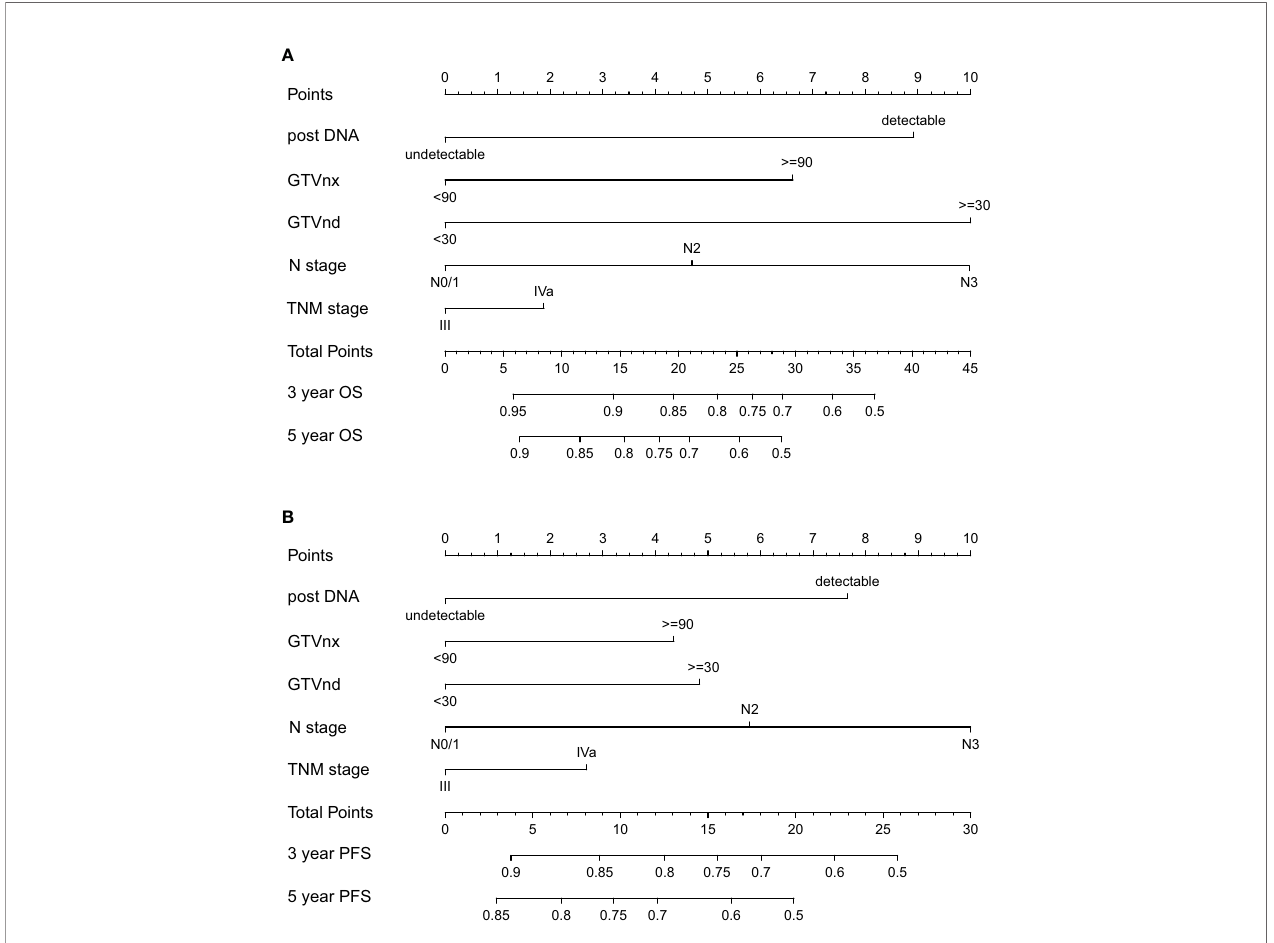
FIGURE 1 | Nomogram integrating N stage, TNM stage and all independent clinical factors (post-DNA, GTVnx, and GTVnd) for predicting 3- and 5-year OS (A) and PFS (B)